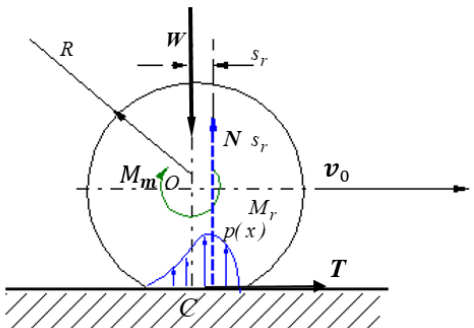
Figure 2. Eccentric position of the normal reaction in a rolling Hertzian contact.